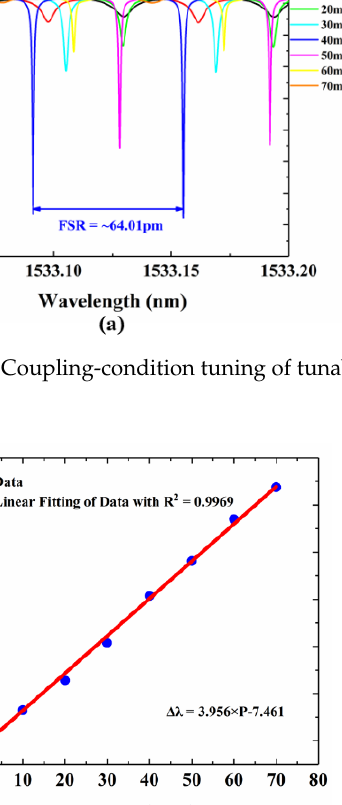
Figure 5. ( a ) Coupling-condition tuning of tunable MRR; ( b ) deepest resonant peak with Lo- rentzian fitting.